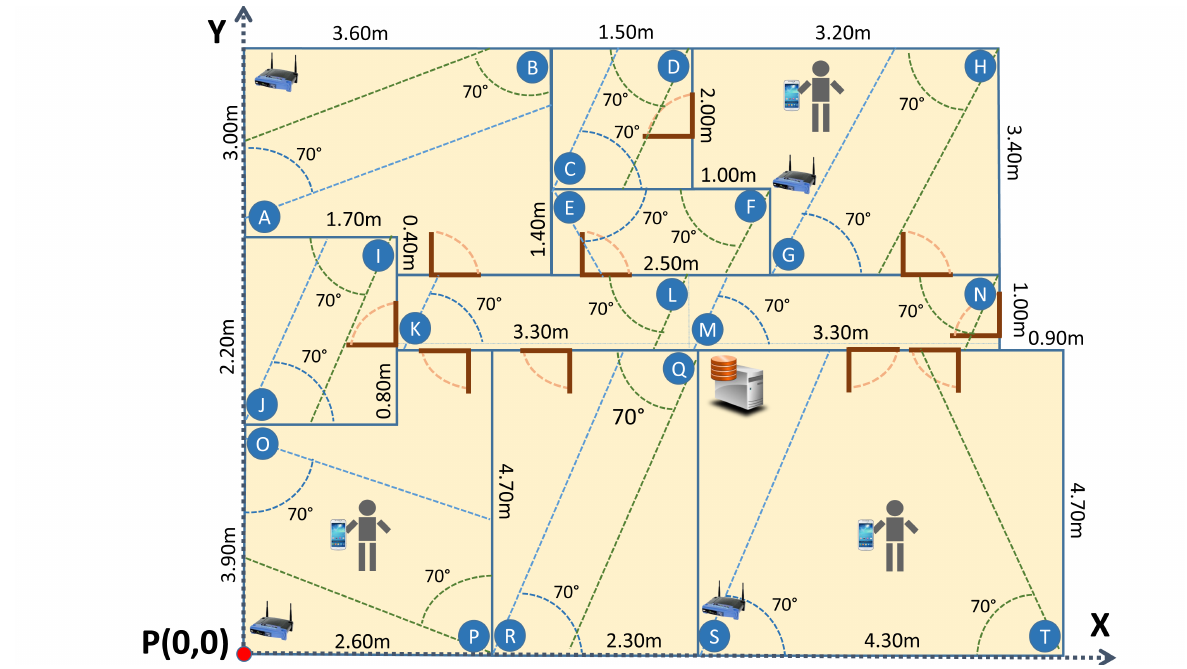
Figure 7. Plan of the office used in the experiments.